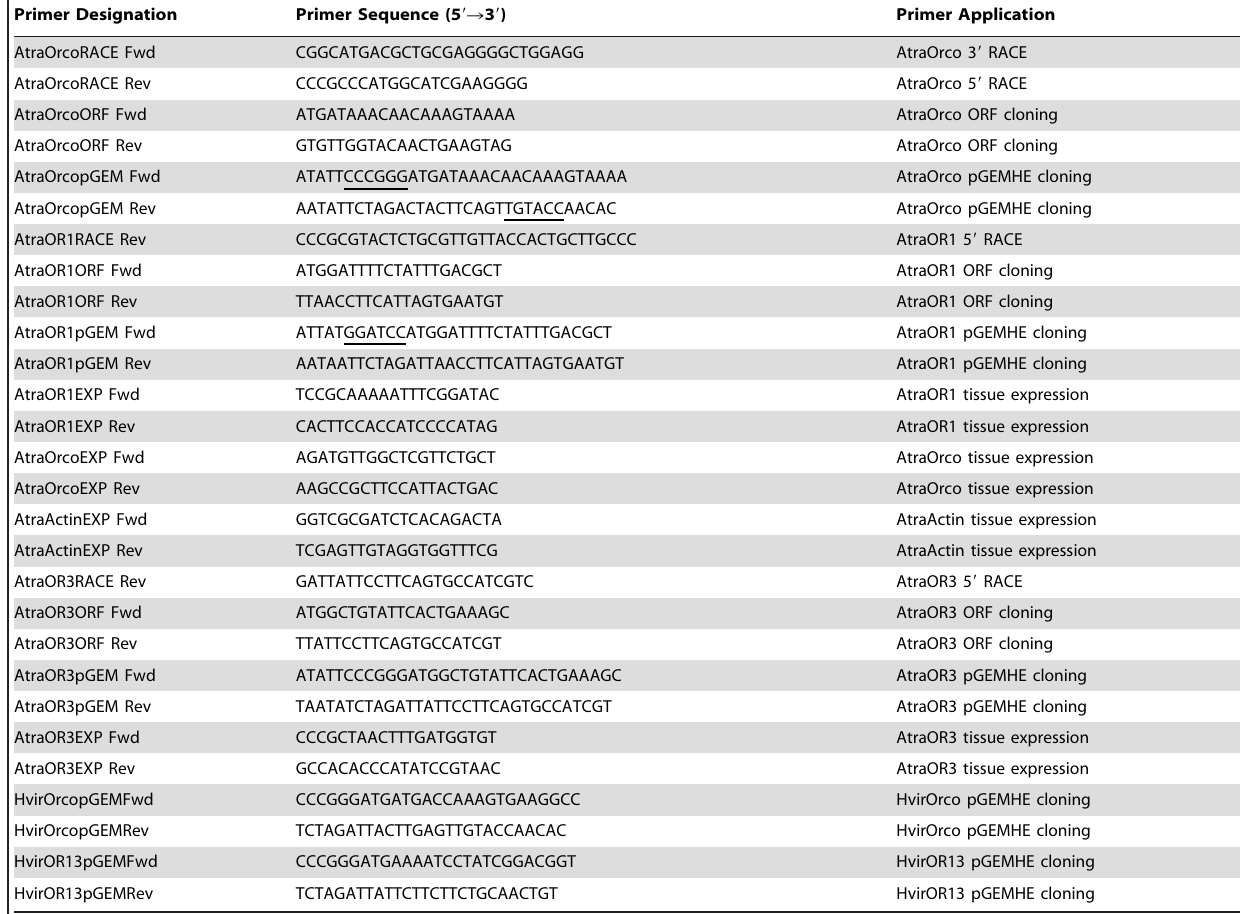
Table 1. Oligonucleotide primers used in this